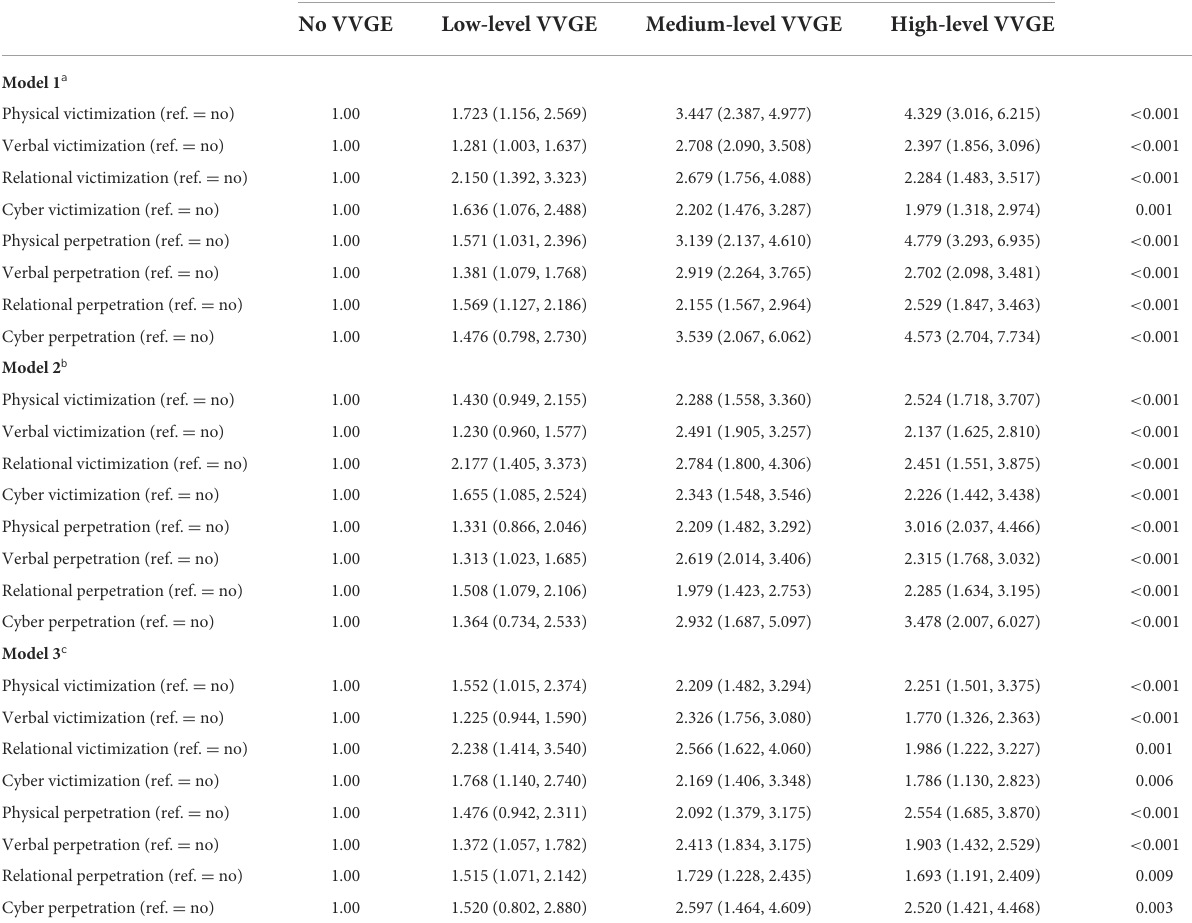
TABLE 3 Multiple logistic regression analysis of sub-types of school bullying and violent video game exposure [OR (95% CI)].